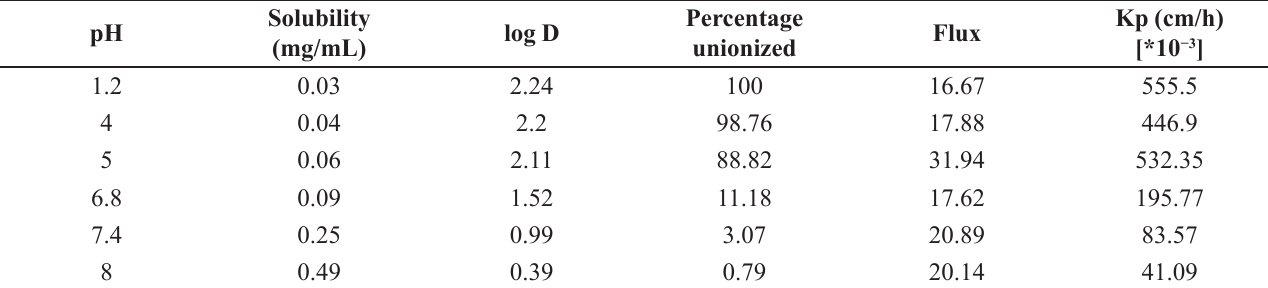
TABLE III - Solubility, distribution coefficient, percentage unionized, and skin permeability parameters of Glipizide